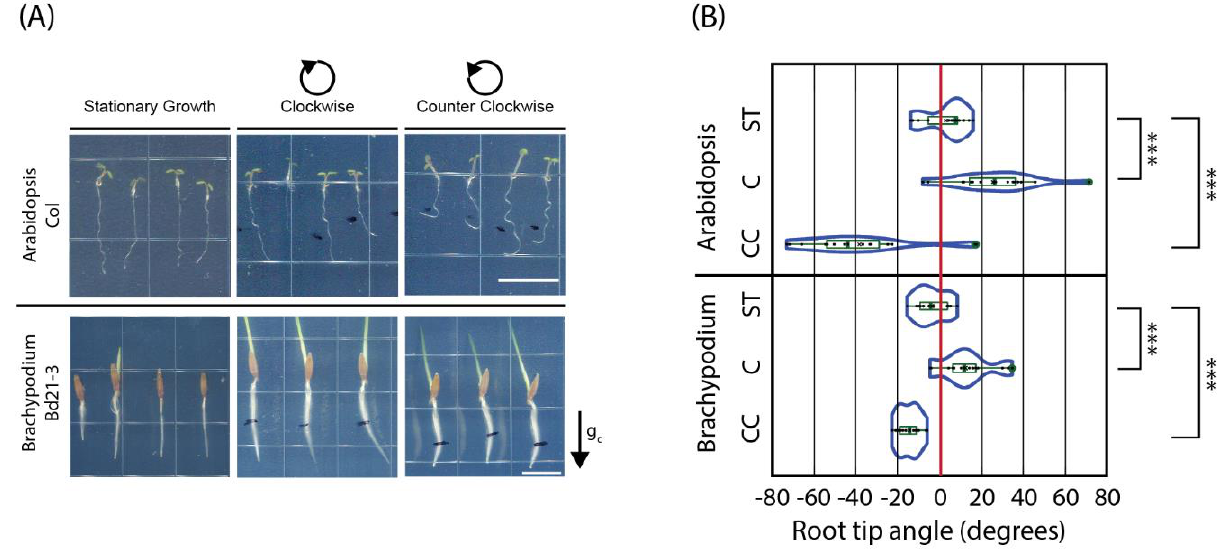
Figure 1. Representative root tips of Arabidopsis thaliana and Brachypodium distachyon seedlings curve in response to low-speed vertical clinorotation: ( A ) 5-day-old Arabidopsis (Col, upper panel) and 3-day-old Brachypodium (Bd21-3, lower panel) seedlings were clinorotated clockwise (C) or counterclockwise (CC) at 0.2 RPM or stationary growth (ST) in darkness for 24 h. Rotation direction is defined based on observations from the back of the plates, through the agar-based medium; g c refers to the gravity vector at the onset of clinorotation; white bars refer to 1 cm. ( B ) Quantification of root tip angles at the end of clinorotation ( n = 12 to 17). The distributions of root tip angles for each experiment are represented as violin plots. The box plots within each violin indicate median (horizontal bar) and mean values (X), along with the quartiles (rectangular boxes) and standard deviations (whiskers) of the distributions. *** Refers to the t -test p -value of < 0.001. These experiments were repeated twice, with similar